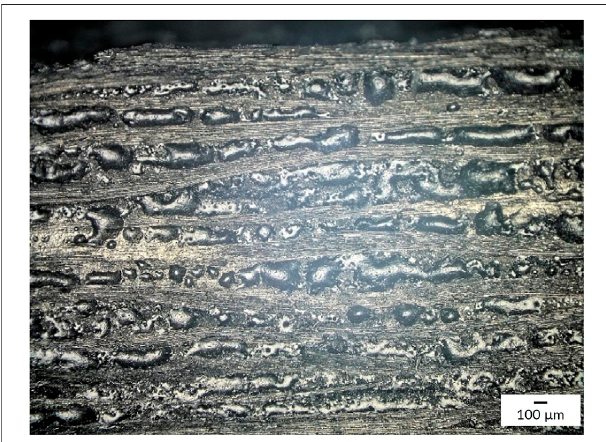
FIGURE 8 | Optical microscopy image showing the bleeding of the healing agent on the cross-section of a [(0/90)] 18 H2 sample after the healing treatment.